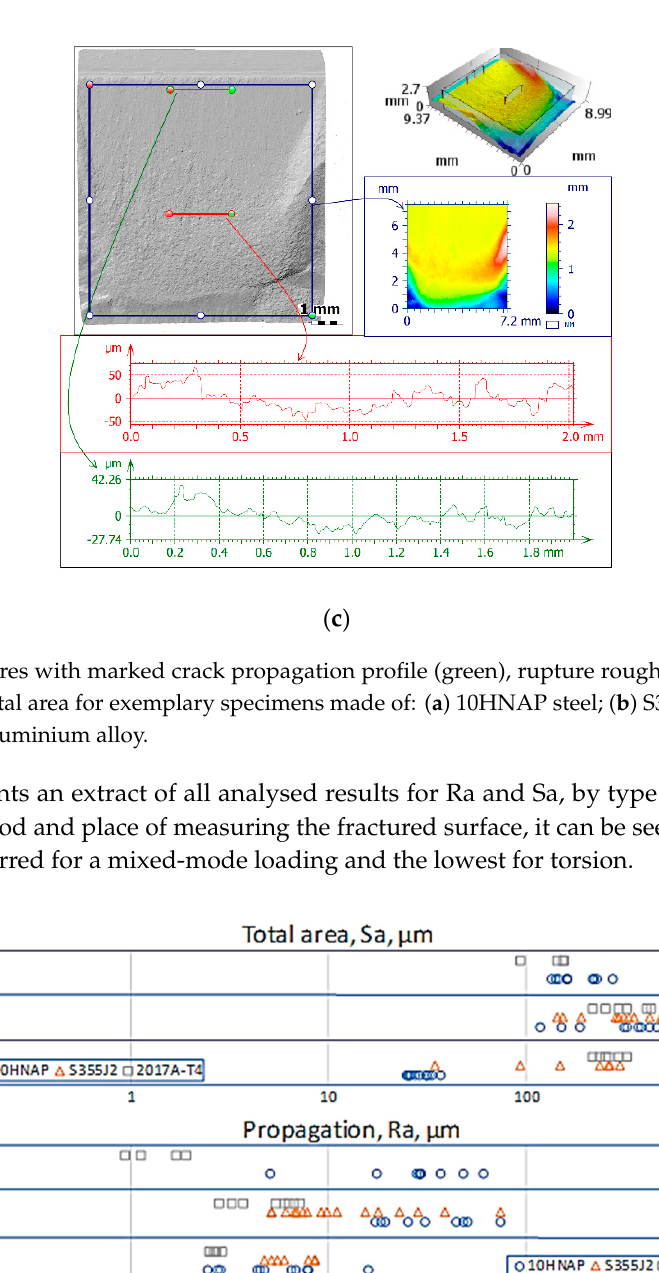
( c ) Figure 9. Surface parameters for the investigated fracture areas: ( a ) total area; ( b ) propagation profile; and ( c ) rupture profile. Table 5. List of maximum and minimum values of surface parameters for individual reference area. Method